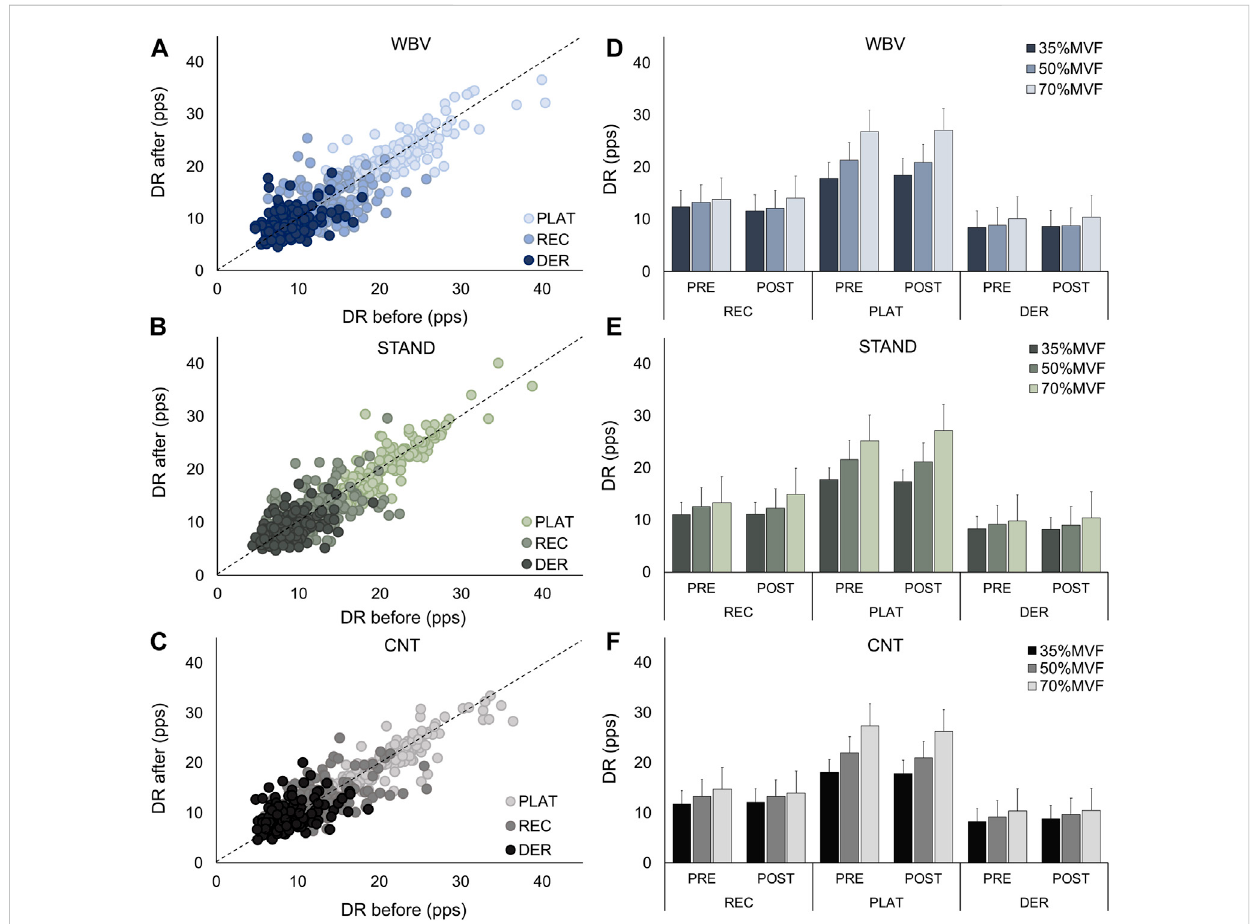
FIGURE 7 Discharge rate at the recruitment, plateau, and derecruitment. In the left panels, scatter plots of the discharge rate at the recruitment, plateau, and derecruitment for each given target force are displayed, with the discharge rate before (on the abscissa) and the discharge rate after (on the ordinate). Panels (A – C) representWBV,STAND,andCNTconditionsrespectively.Thepanelsontherightdisplaybarplotsofthedischargerateateachtargetforce ’ s recruitment, plateau, and derecruitment. Panels (D – F) represent WBV, STAND, and CNT conditions respectively. Data are reported as mean ±